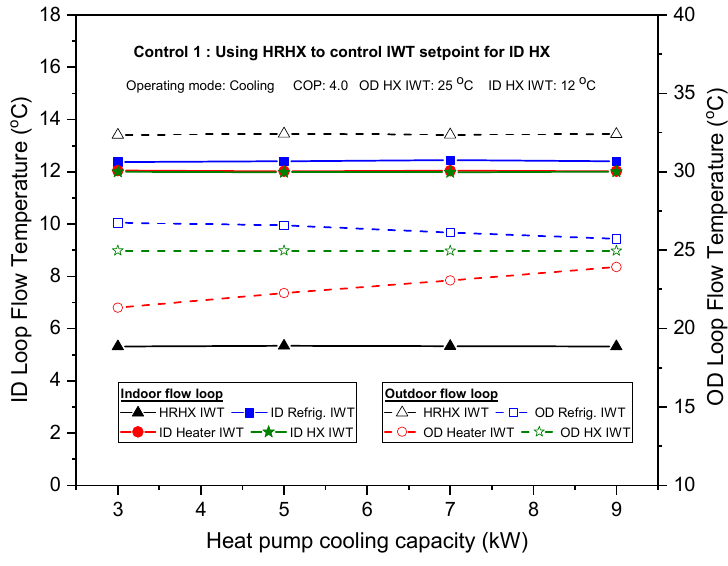
Figure 10. Flow loop temperature with variation in heat pump cooling capacity for control (1).